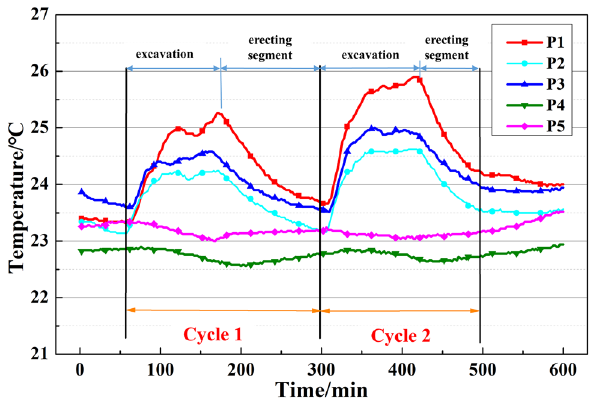
Figure 12. The temperature of cutterhead on April 10, 2018.